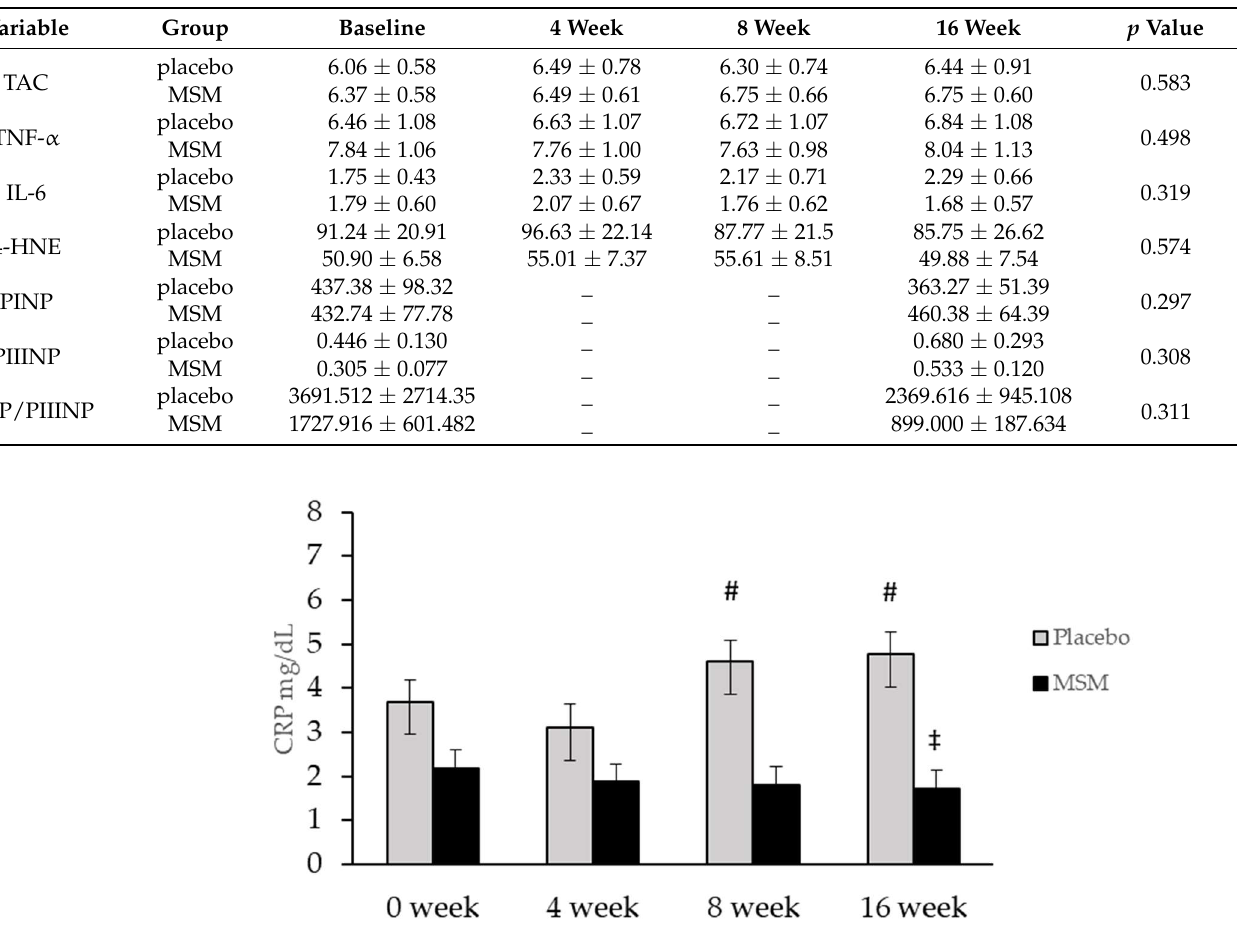
Figure 4. C-reactive protein (CRP) levels were lower in the MSM group compared to placebo at week 16. However, the placebo group showed increased CRP levels at week 8 and 16 compared to week 4. # Significantly different from week 4, p ≤ 0.05; ‡ significantly different from placebo group, p ≤ 0.05.